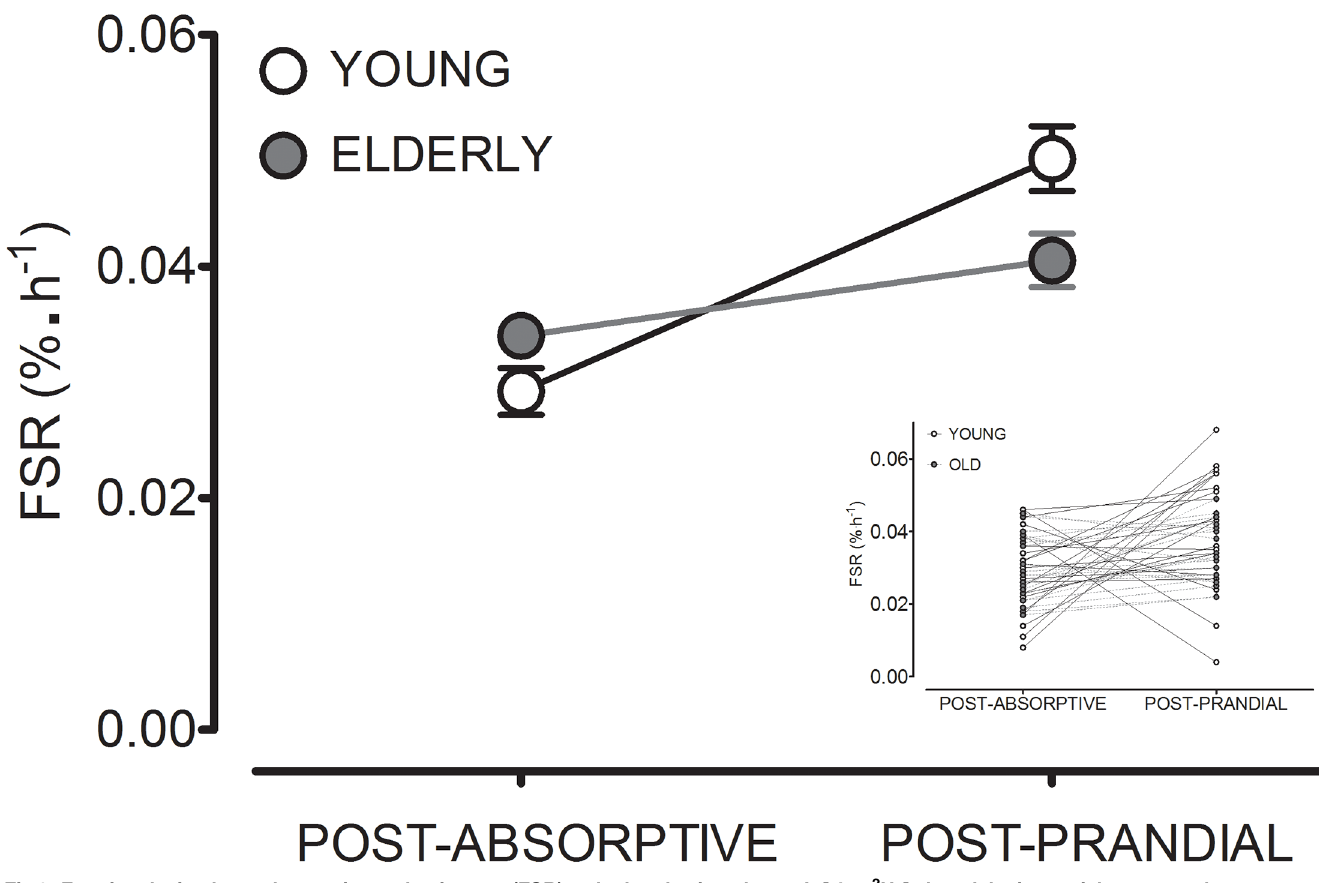
Fig 2. Fractional mixed muscle protein synthesis rates (FSR), calculated using plasma L-[ ring - 2 H 5 ] phenylalanine enrichments as the precursor pool, in healthy young and elderly men in the post-absorptive state ( n = 34 young and n = 72 elderly) and following the ingestion of 20 g protein (post-prandial; n = 35 young and n = 40 elderly. Delta increases from post-absorptive to post-prandial were analyzed between groups using an unpaired t - test (significantly different; P < 0.01). Individual responses are reported in the inset figure only in those subjects for whom post-absorptive and post-prandial muscle protein synthesis rates were assessed within the same experiment ( n = 55 [22 young and 23 elderly]).